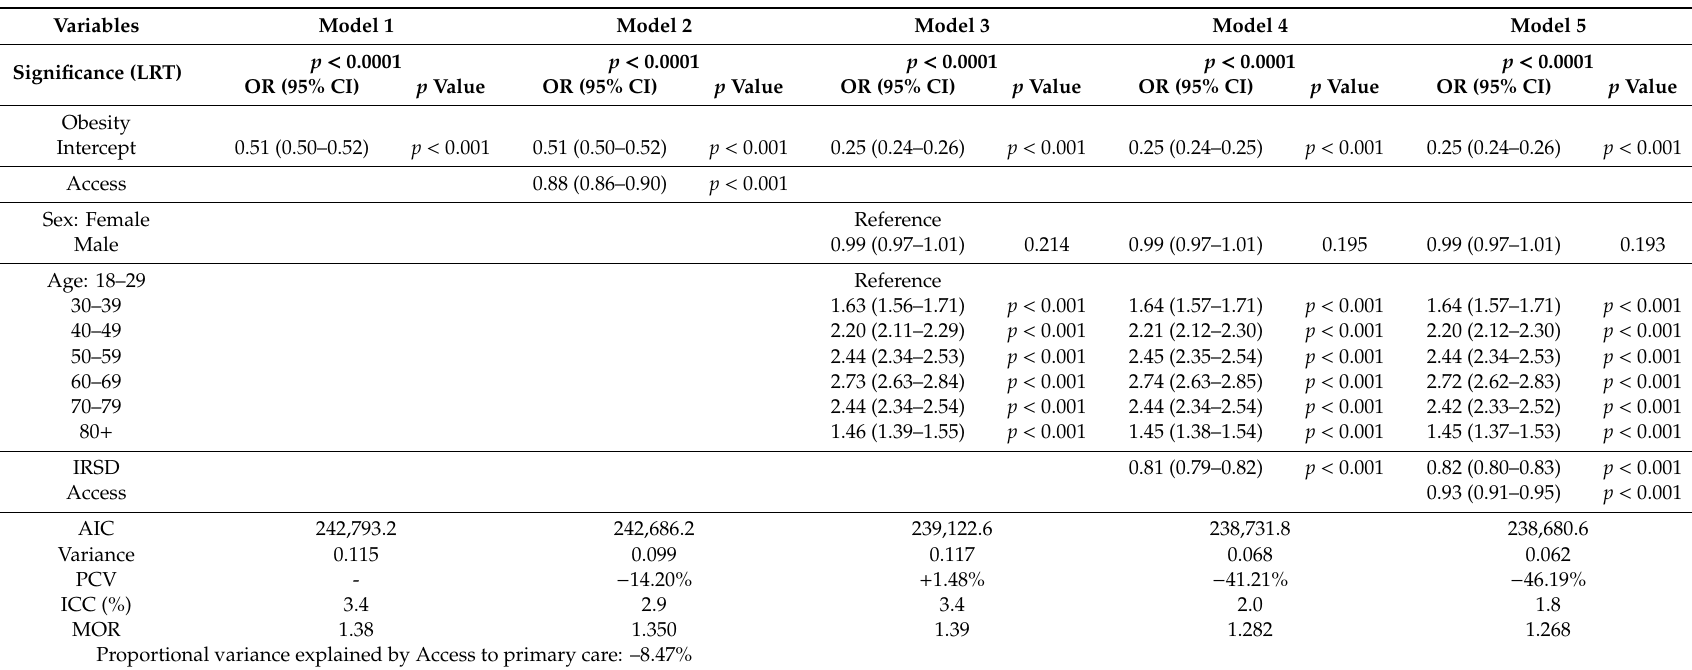
Table 9. Multilevel logistic regression model summaries of obesity (BMI ≥ 30 kg / m 2